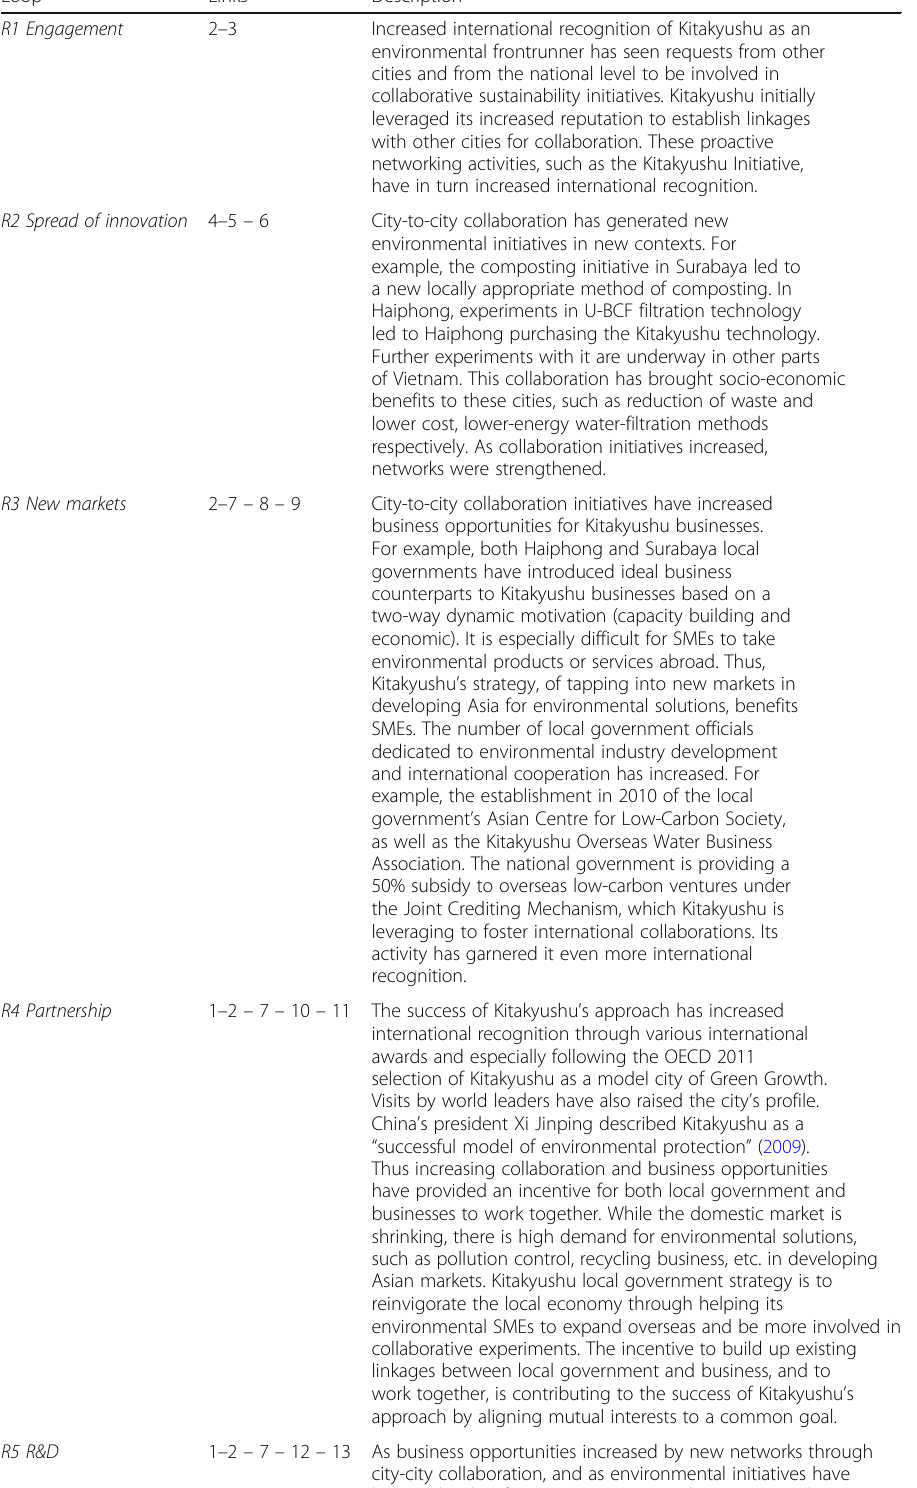
Table 5 Explanation of feedback loops from city-city collaboration shown in Fig. 3. Internal success attracted the attention of other cities in the region Loop